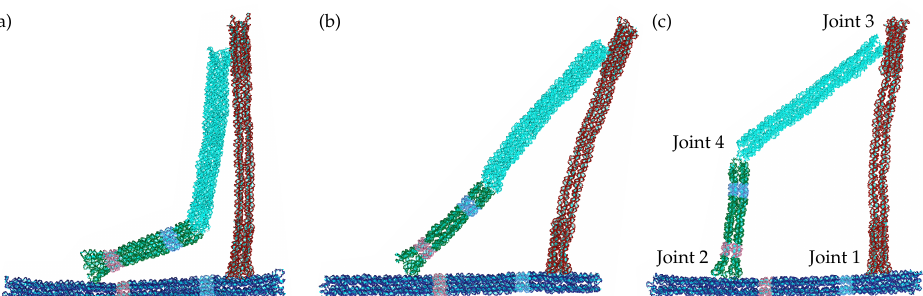
Figure 1. Representative oxDNA configurations of the origami in ( a ) the closed state S1 ( θ ≈ 20 ◦ ) ( b ) the intermediate state U ( θ ≈ 45 ◦ ) and ( c ) the open state S2 ( θ ≈ 80 ◦ ). The four joints are numbered in ( c